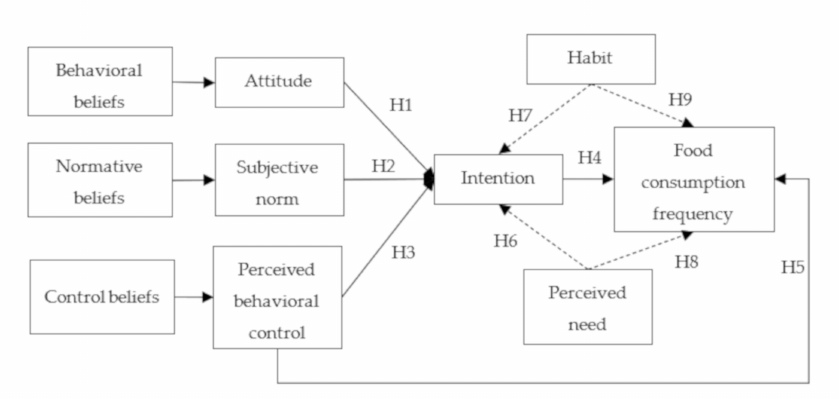
Figure 1. Specification of the extended theory of planned behavior (TPB) model and tested